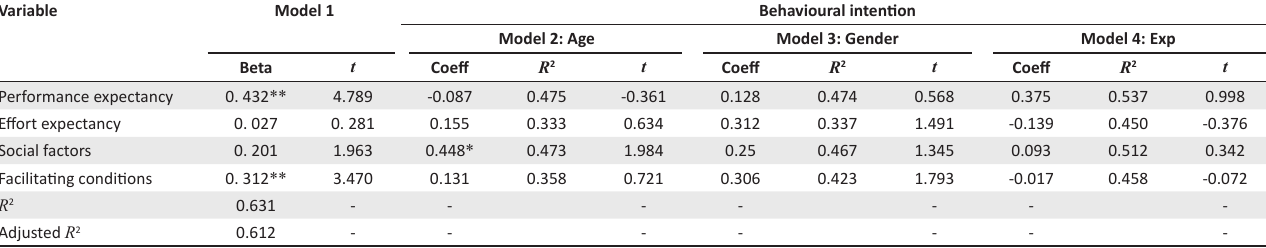
TABLE 3: Results of the linear and moderated regression analyses.